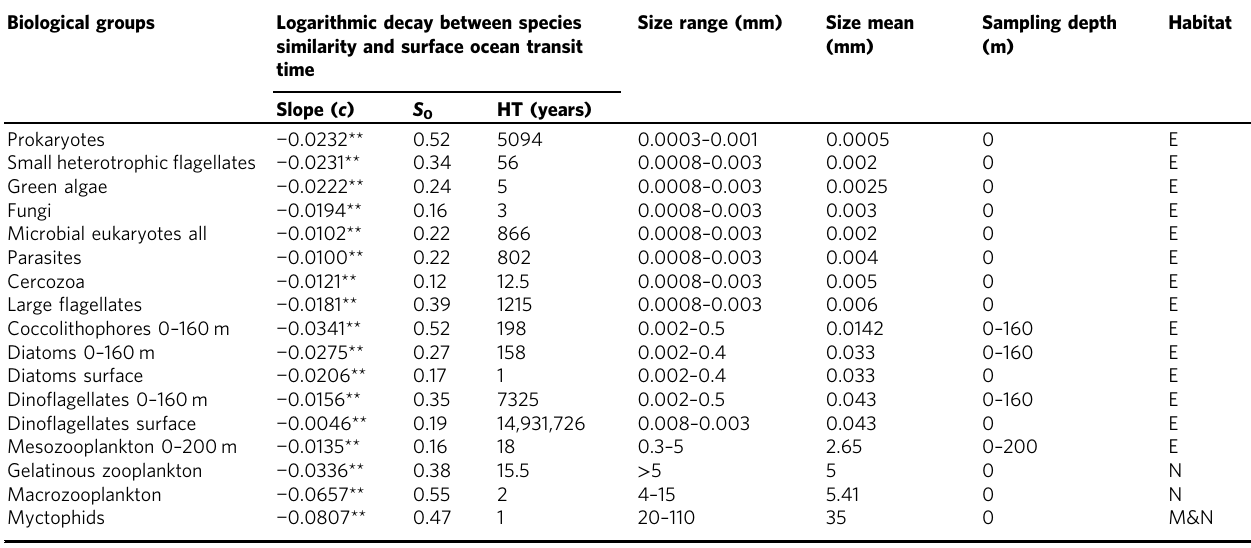
Table 2 Halving-times for each biological group Biological groups Logarithmic decay between species similarity and surface ocean transit